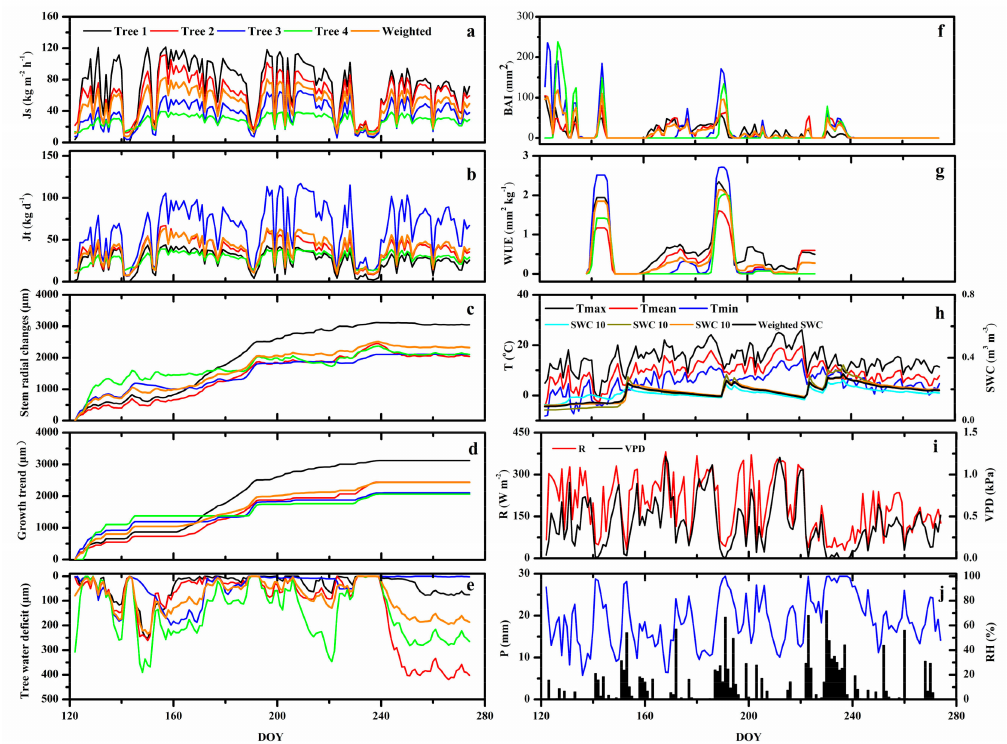
Figure 2. Time series of sap flow density (Js) ( a ), sap flow (Jt) ( b ), stem radial changes ( c ), growth trends ( d ), tree water deficit ( e ), basal area increment (BAI) ( f ) and water use efficiency (WUE) ( g ) in four sample trees from the day of year (DOY) 122 to 274 of 2016; air temperature (T) and soil water content (SWC) ( h ), daily mean solar radiation (R) and vapor pressure deficit (VPD) ( i ), precipitation (P) and relative air humidity (RH) ( j